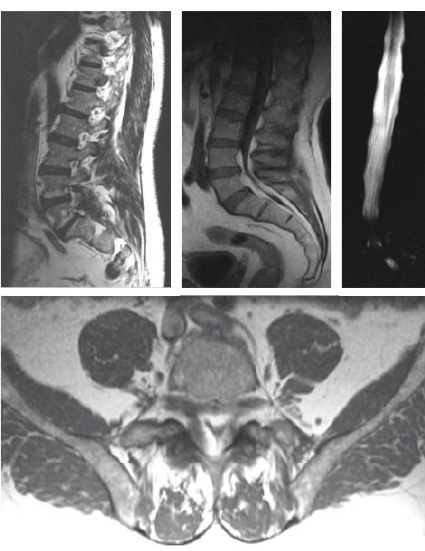
Figure 1: Preoperative MR. T1-weighted axial and sagittal image showed Y sign and thin dural sac. MR-myelogram shows stop at L4-S1 levels. Sagittal T2- (left) and T1- (right) weighted MR images showing Modic type I endplate change at the L4-L5 and L5-S1 levels consisting of low signal intensity on T1 images and high signal intensity on T2 images.